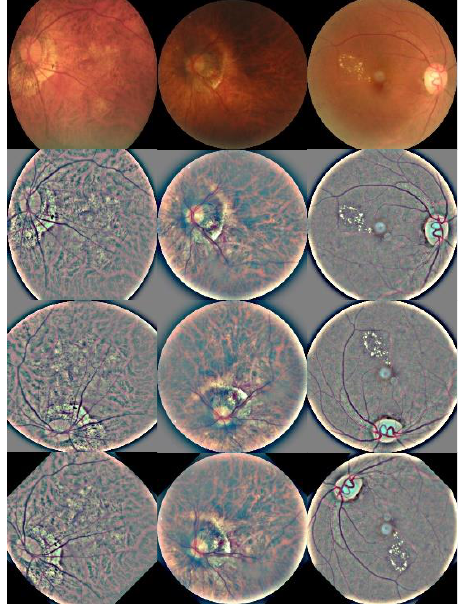
Figure 6. Image augmentation results.